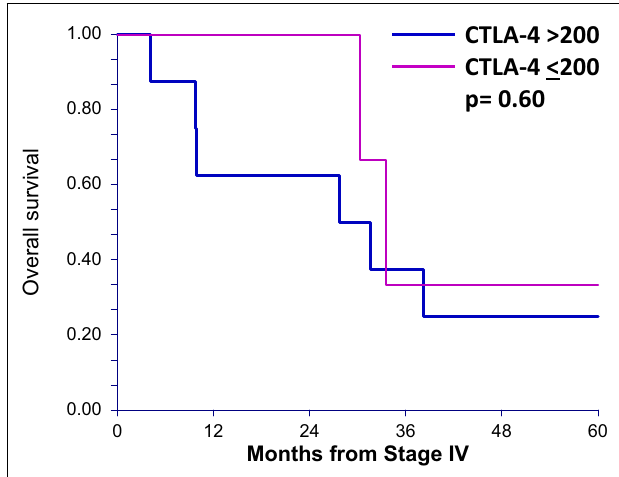
FIGURE 3 | Overall survival after stage IV diagnosis in patients not receiving ipilimumab treatment is not different in patients with serum sCTLA4 levels above 200pg/mL . Overall survival curves (up to 5years) of patients who did not receive ipilumumab comparing those with greater than 200pg/mL serum sCTLA4 to those with less than or equal to